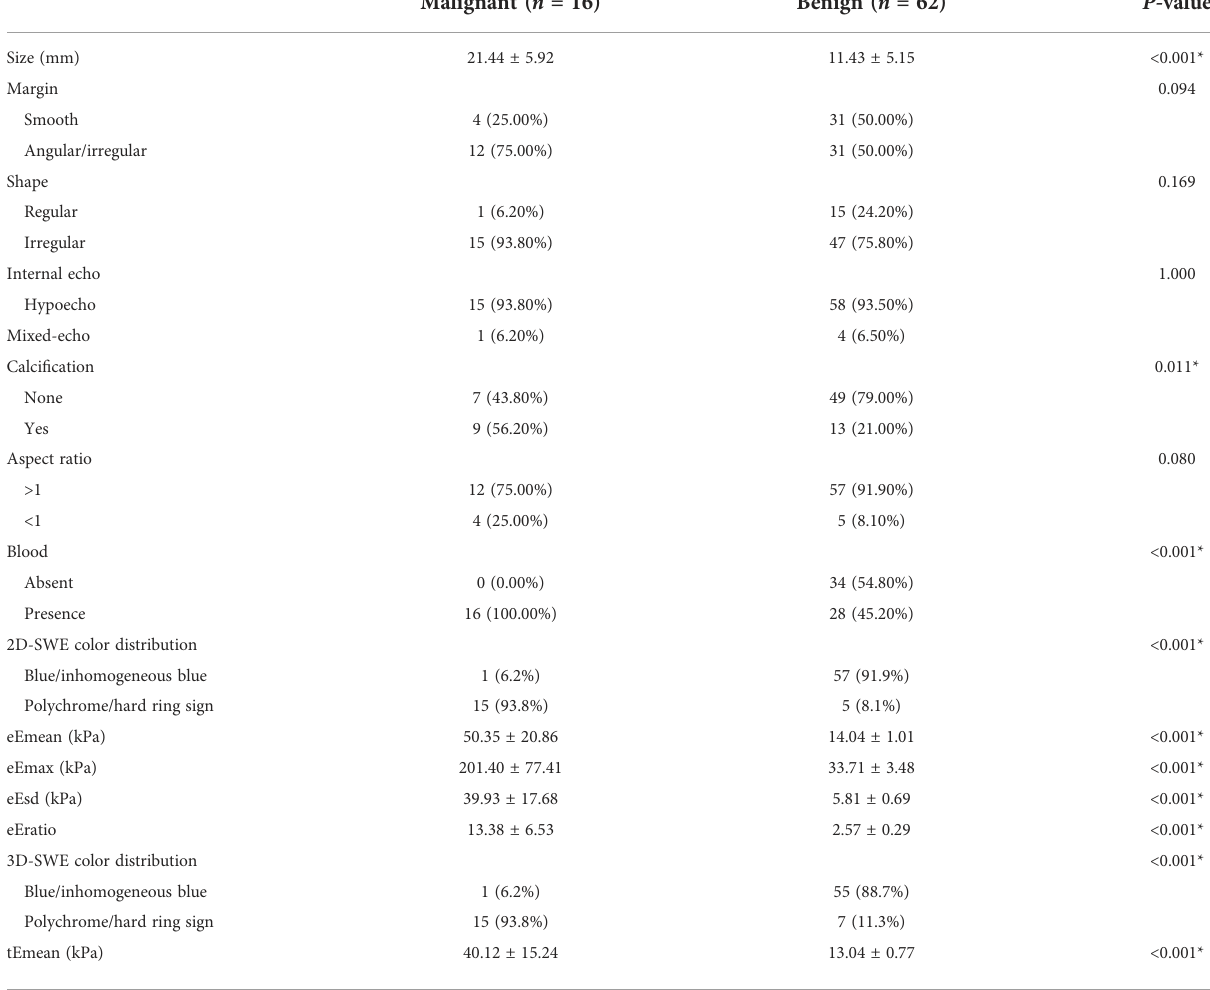
TABLE 2 Ultrasonographic features of category BI-RADS 4 breast neoplasms in the training